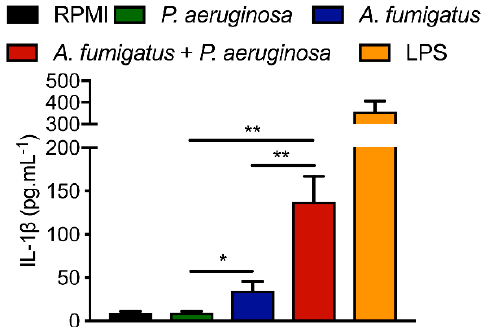
Figure 7. Previous bacterial challenge synergistically increases the production of IL1 β in response to A. fumigatus . Monocytes were stimulated by RPMI medium (in black), bacterial lipopolysaccharide (LPS, 10ng / mL, in orange), P. aeruginosa alone (in green), A. fumigatus alone (in blue), P. aeruginosa–A. fumigatus sequential infection (in red) according to protocol described in Supplementary Materials. Stars represent statistical di ff erence (* p < 0.05; ** p <